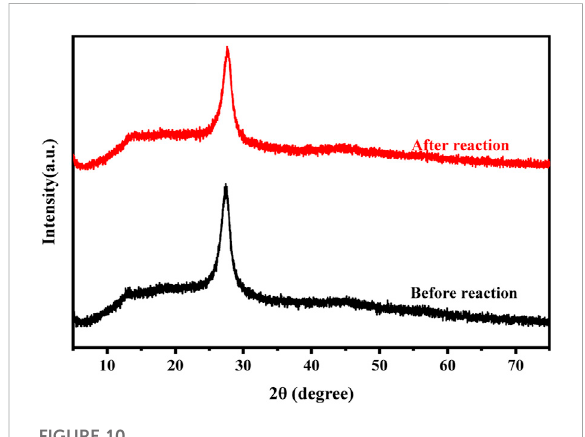
FIGURE 10 XRD patterns of CuCo/SCN before and after reaction.